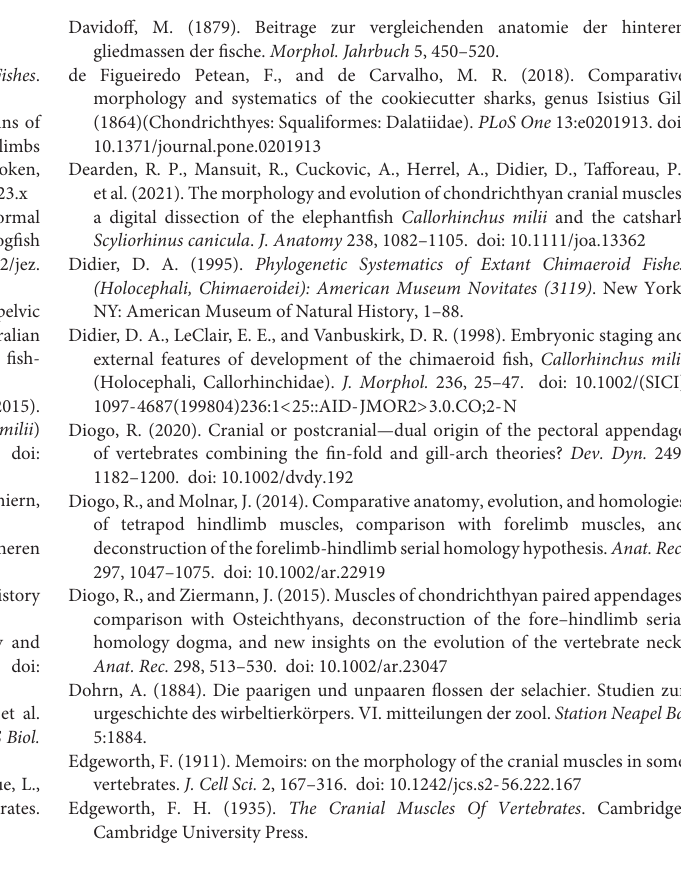
Supplementary Figure 1 | Illustration of the pelvic skeleton of a female elephant shark ( Callorhinchus milii ). Supplementary Figure 2 | Photographed images of dissected elephant shark pelvic musculature ( Callorhinchus milii ) from Figure 1 without color overlays. Supplementary Figure 3 | Photographed images of dissected elephant shark ventral pelvic musculature ( Callorhinchus milii ) from Figure 2 without color overlays. Supplementary Figure 4 | Photographed images of dissected elephant shark reproductive musculature ( Callorhinchus milii ) from Figure 3 without color